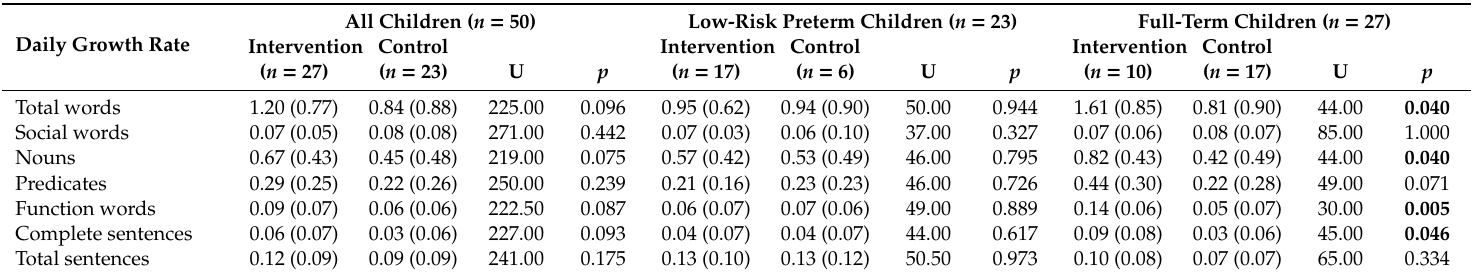
Table 5. Children’s daily growth rate in expressive lexical and syntactic skills from pre- to post-intervention assessment. Daily Growth